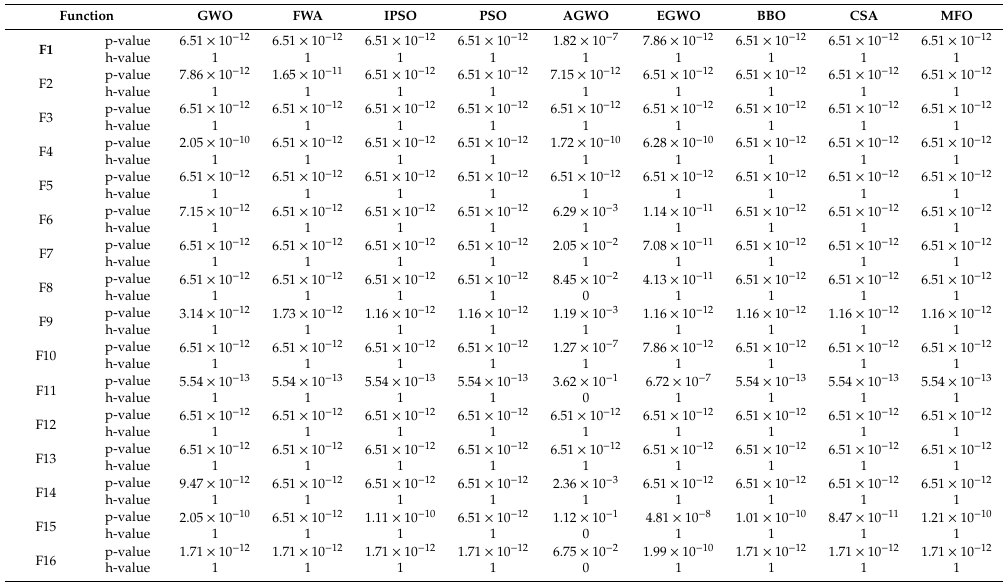
Table 4. Wilcoxon’s rank test of FWGWO and other algorithms on 16 benchmark